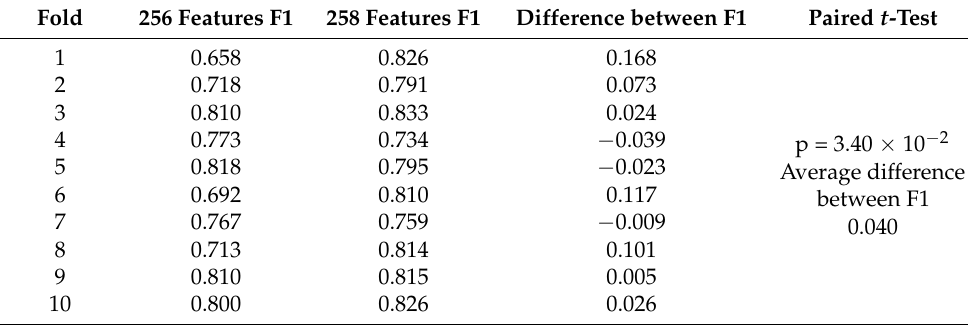
Table 11. Paired t -test of F1-score for 258 features w/wo K-Means SMOTE. Fold 258 Features